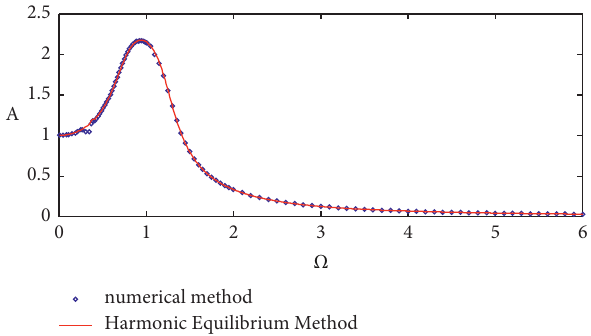
Figure 3: The response of nondimensional amplitude-frequency using harmonic equilibrium method and numerical method ( ζ � 0.1, n � 1, and b �